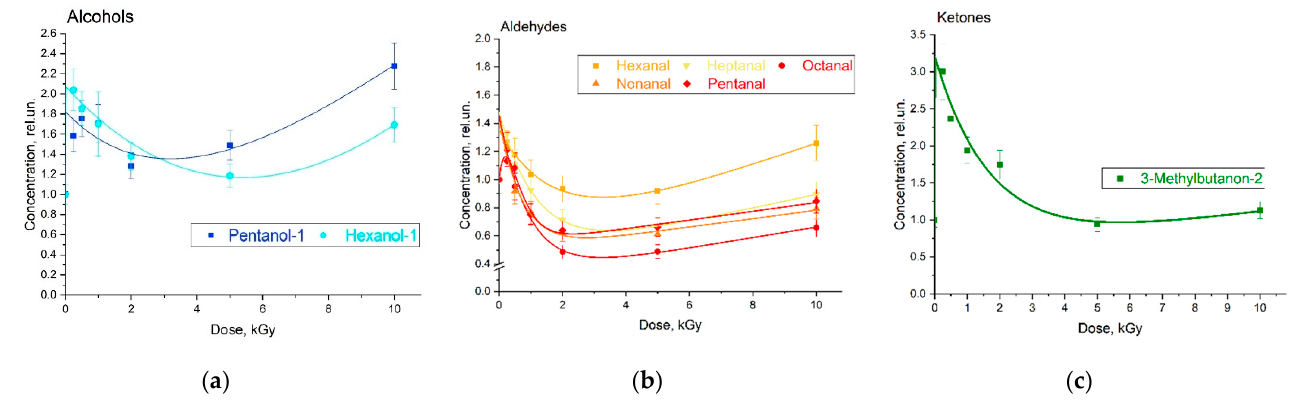
Figure 4. The dependencies of the concentrations of alcohols ( a ), aldehydes ( b ), and ketones ( c ) in turkey samples on the irradiation dose and the corresponding functions, calculated by Equation (5). The function parameters calculated by Equation (5) for each identified compound, as well as the correlation coefficients corresponding to them, are presented in Table 2. The values of the correlation coefficients indicate the adequacy of the proposed mathematical model for describing the behavior of organic volatile compounds in turkey meat after ex- posure to accelerated electrons in various doses. Table 2. Function parameters for different organic compounds. The Function